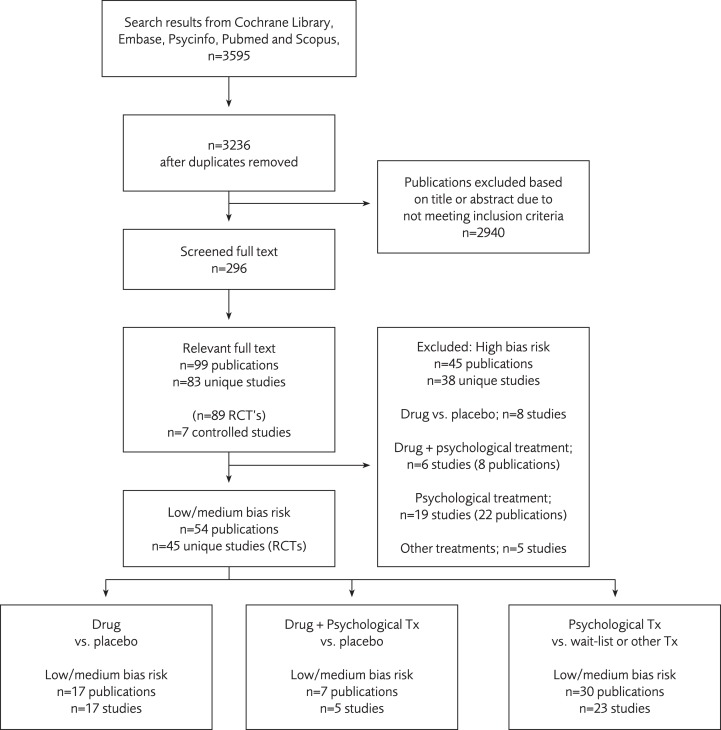
Search results and inclusion of the studies.